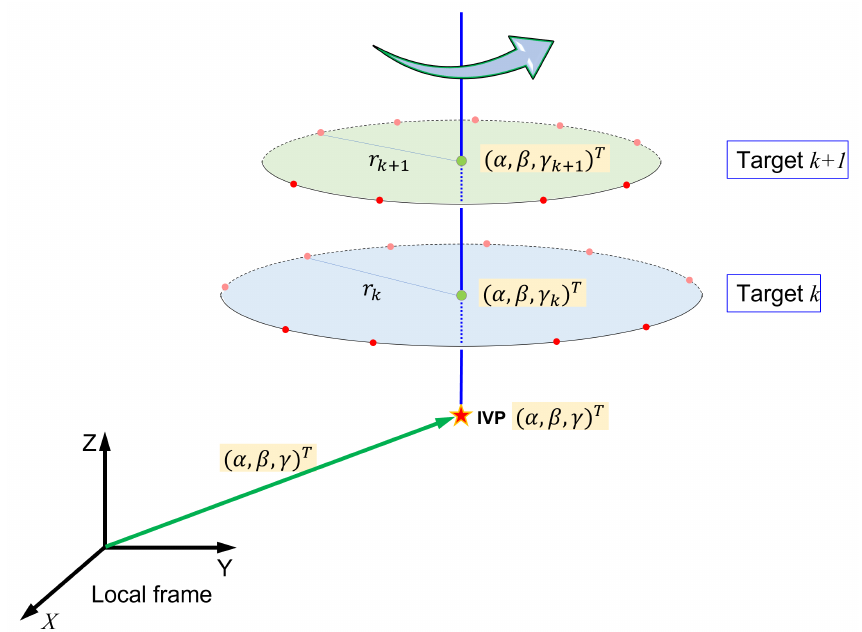
Figure 3. The azimuthal trace of two targets. The horizontal planes generated by each target share the common normal vector as well as the horizontal coordinates of the